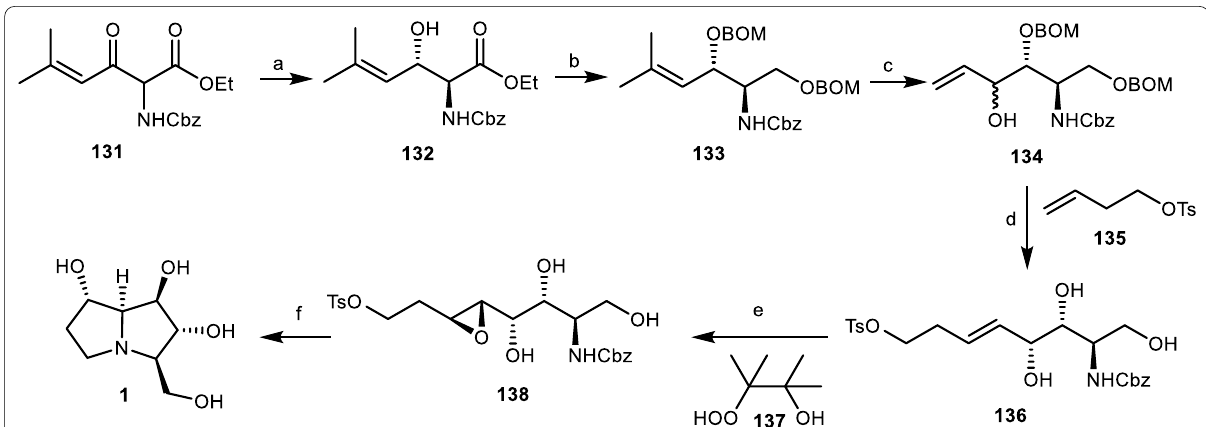
Scheme 11 The synthesis of the alexine 1 by Somfai et al. Reagents and conditions : (a) [RuCl 2 (mesitylene)] 2 , ( S,S )-DPAE, HCO 2 H/EtN 3 , dioxane, r.t., 77%; (b) (i) NaBH 4 , EtOH, r.t.; (ii) BOMCl, i -PrNEt 2 , CHCl 3 , r.t., 78%; (c) (i) O 3 /DMS, CH 2 Cl 2 , to r.t., 58%; (d) (i) Grubbs’ catalyst,